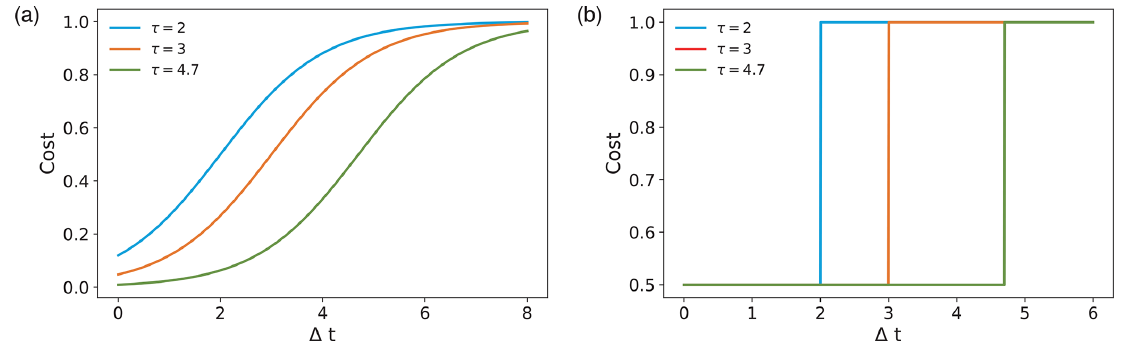
Figure 6. Variation of the cost contributed by shifting an event by (cid:49)t for different parameter values τ = 2 , 3 , and 4 . 7 using (a) the logistic function with k = 1 and (b) the Heaviside